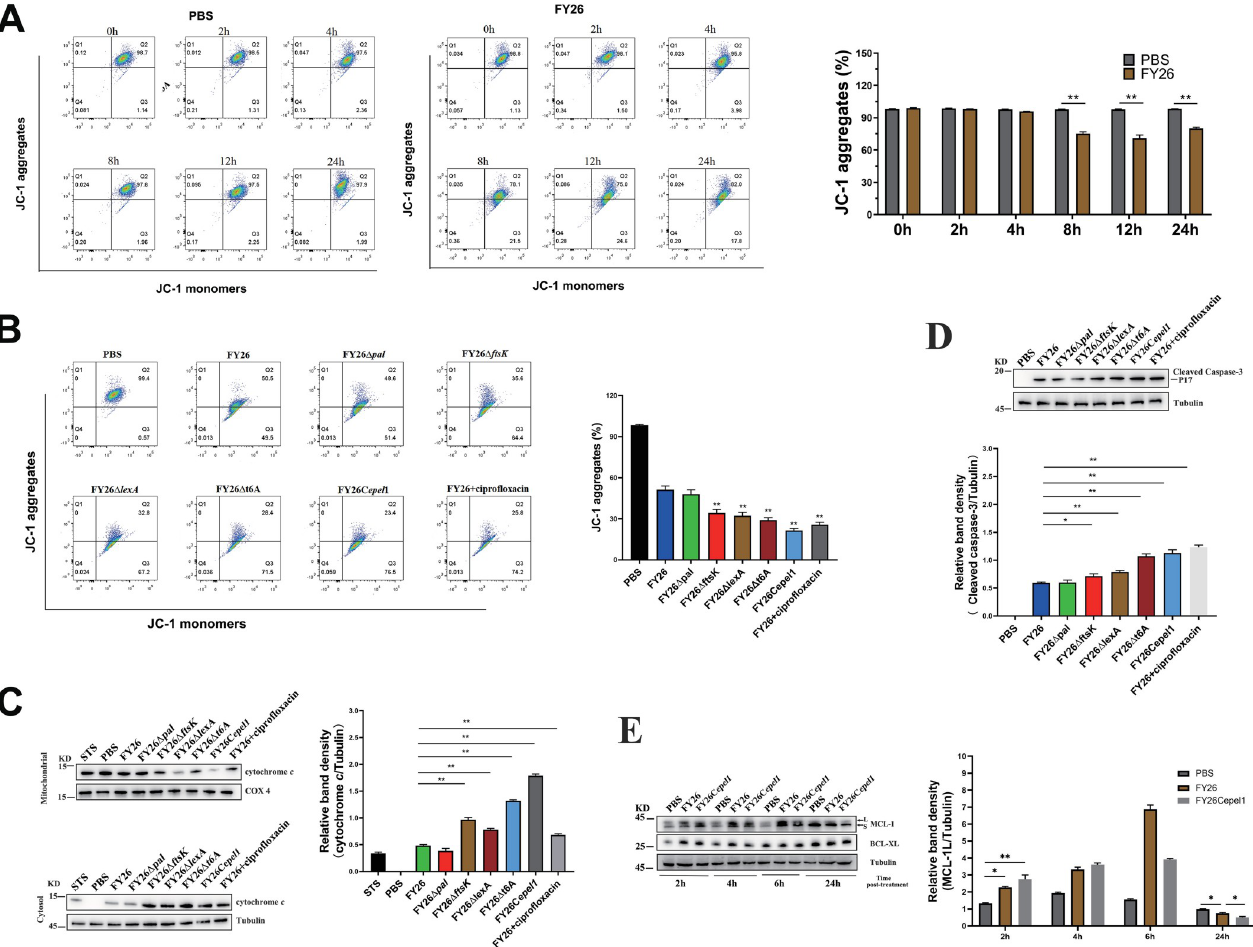
Fig 14. Increased proportion of cytoplasmic vesicles in ExPEC EVs caused more-severe mitochondrial dysfunction and apoptosis in macrophages. (A) Mitochondrial membrane potential ( Δ C m) was determined with JC-1 dye and flow cytometry. Bone-marrow-derived macrophages (BMDMs) were treated with FY26 EVs (50 μ g/mL) or PBS for 0, 2, 4, 8, 12 or 24 h and labeled with JC-1. The percentage of normal cells (JC-1 aggregates) in BMDMs is indicated on the right. (B) Mitochondrial membrane potential ( Δ C m) was determined with JC-1 dye and flow cytometry. Bone-marrow-derived macrophages (BMDMs) were treated with purified ExPEC EVs (50 μ g/mL) or PBS for 12 h and labeled with JC-1. The percentage of normal cells (JC-1 aggregates) in BMDMs is indicated on the right. (C) Cytosolic and mitochondrial fractions of BMDMs were analyzed for cytochrome c with western blotting. BMDMs were treated with purified ExPEC EVs (50 μ g/mL), staurosporine (STS), or PBS for 24 h, anti-tubulin and anti-COX4 were used as the loading control. Molecular weight markers are shown on the left. (D) Levels of caspase 3 (17 kDa) in the BMDMs were determined with western blotting. BMDMs were treated with purified ExPEC EVs (50 μ g/mL) or PBS for 24 h; anti-tubulin was used as the loading control. (E) Levels of MCL-1 and BCL-XL in the BMDMs were determined with western blotting. BMDMs were treated with purified ExPEC EVs (50 μ g/mL) or PBS for 2, 4, 6, or 24h; anti-tubulin was used as the loading